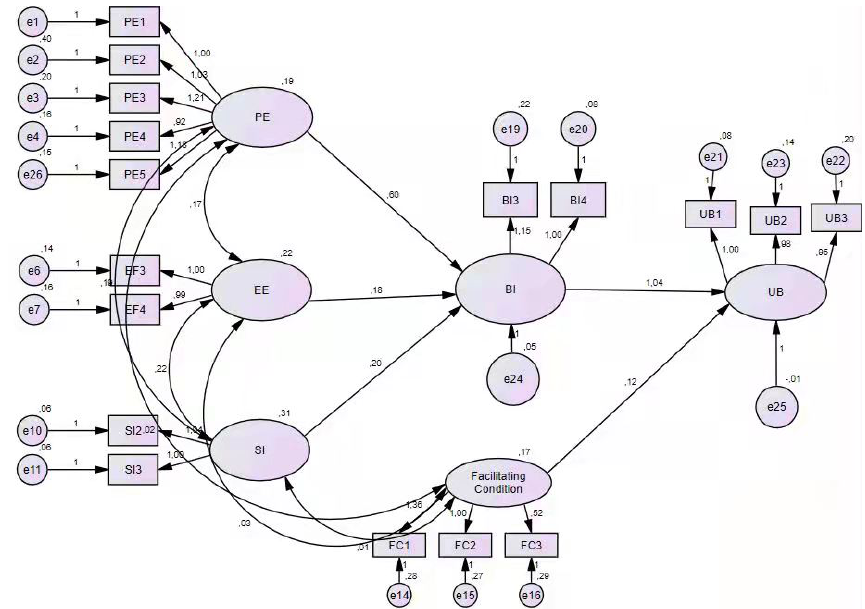
Figure 2. CFA confirmatory factor analysis. Table 7. Relationships between variables in the SEM model. Note: *** p < 0.001. Hypothesis Pathway Estimate (β) Standard Error Critical Ratio